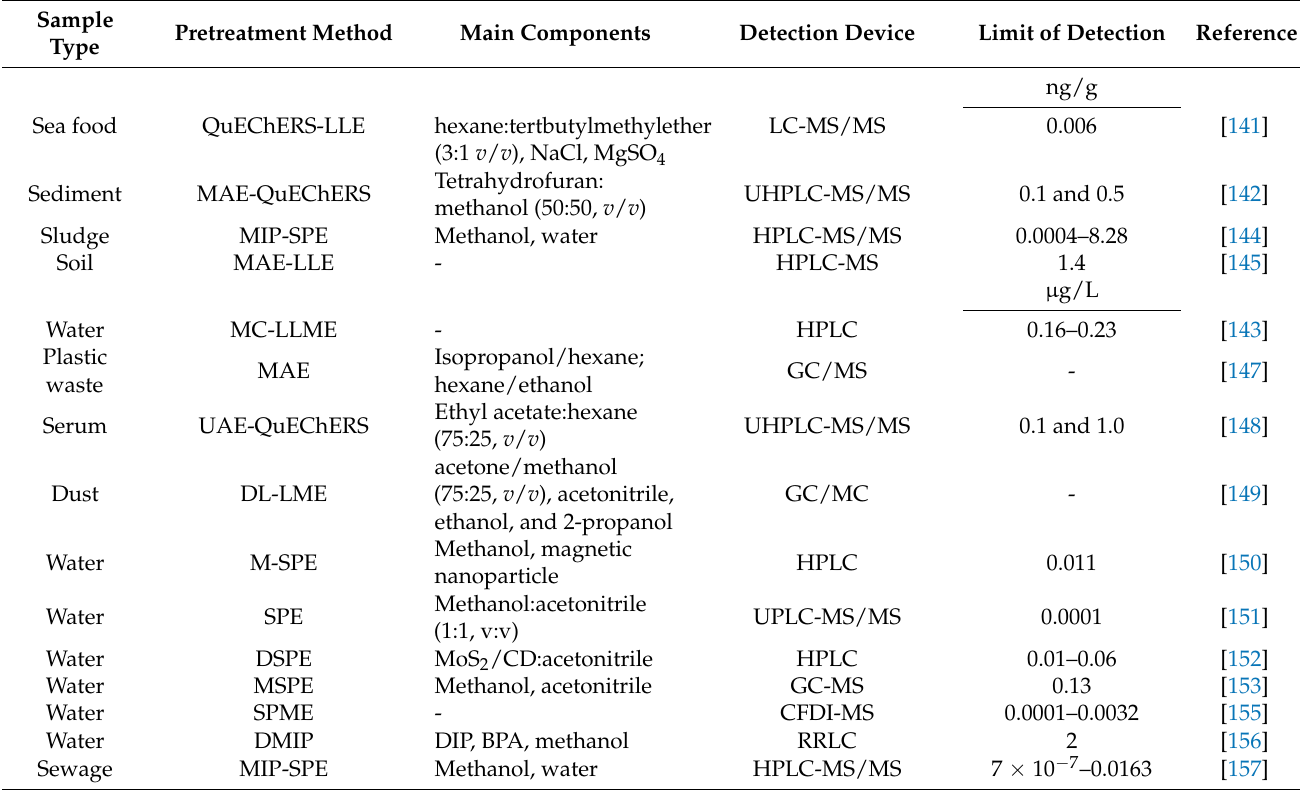
Table 3. Sample pretreatment methods for TBBPA